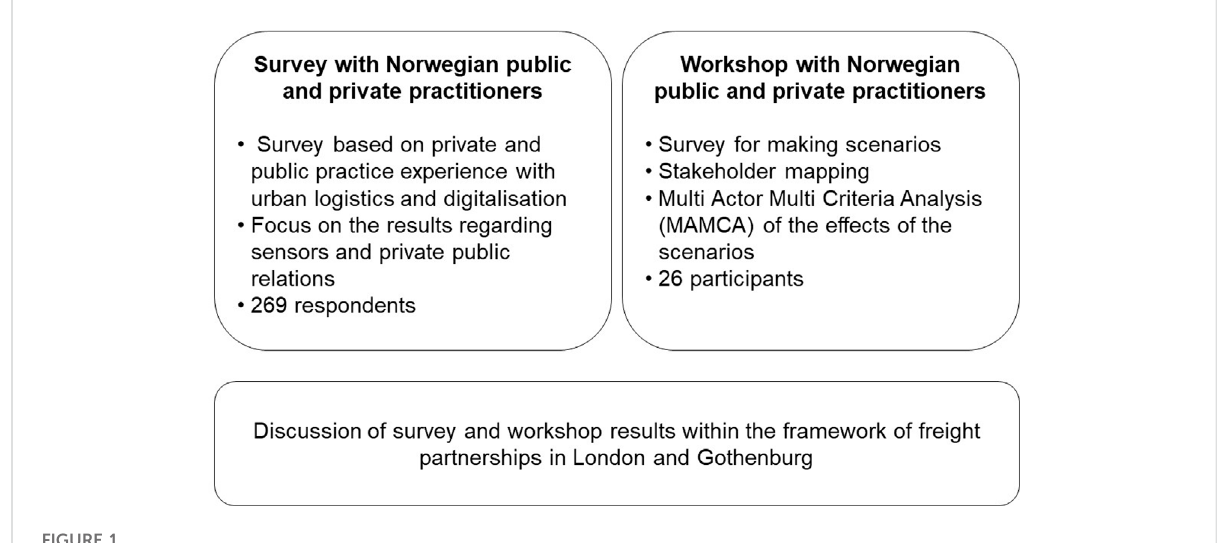
FIGURE 1 The overall framework for the data